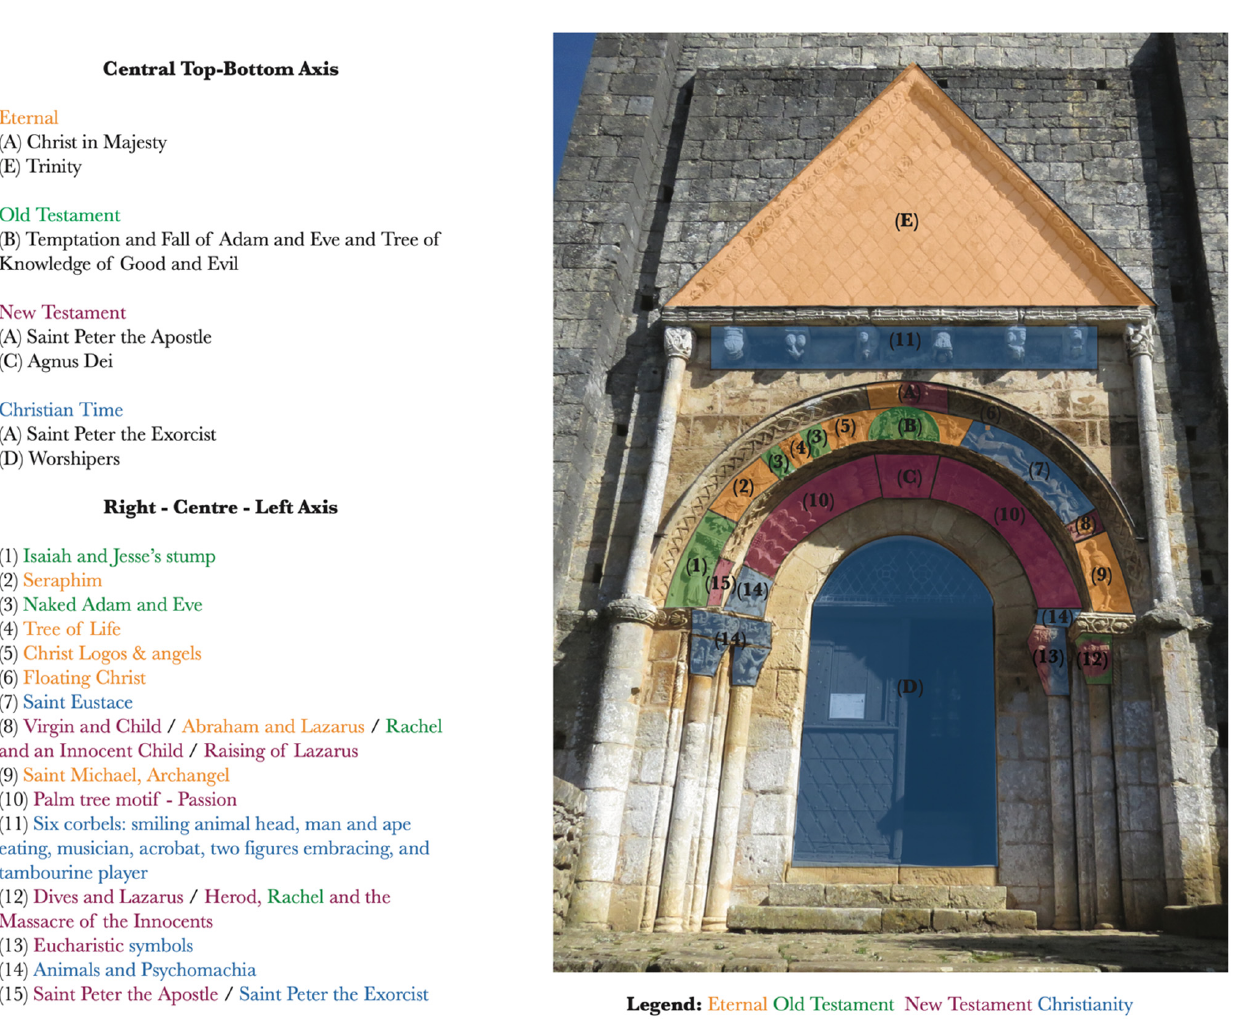
Figure 2. Saint-Martin Church, colour-coded chart. ©Author.